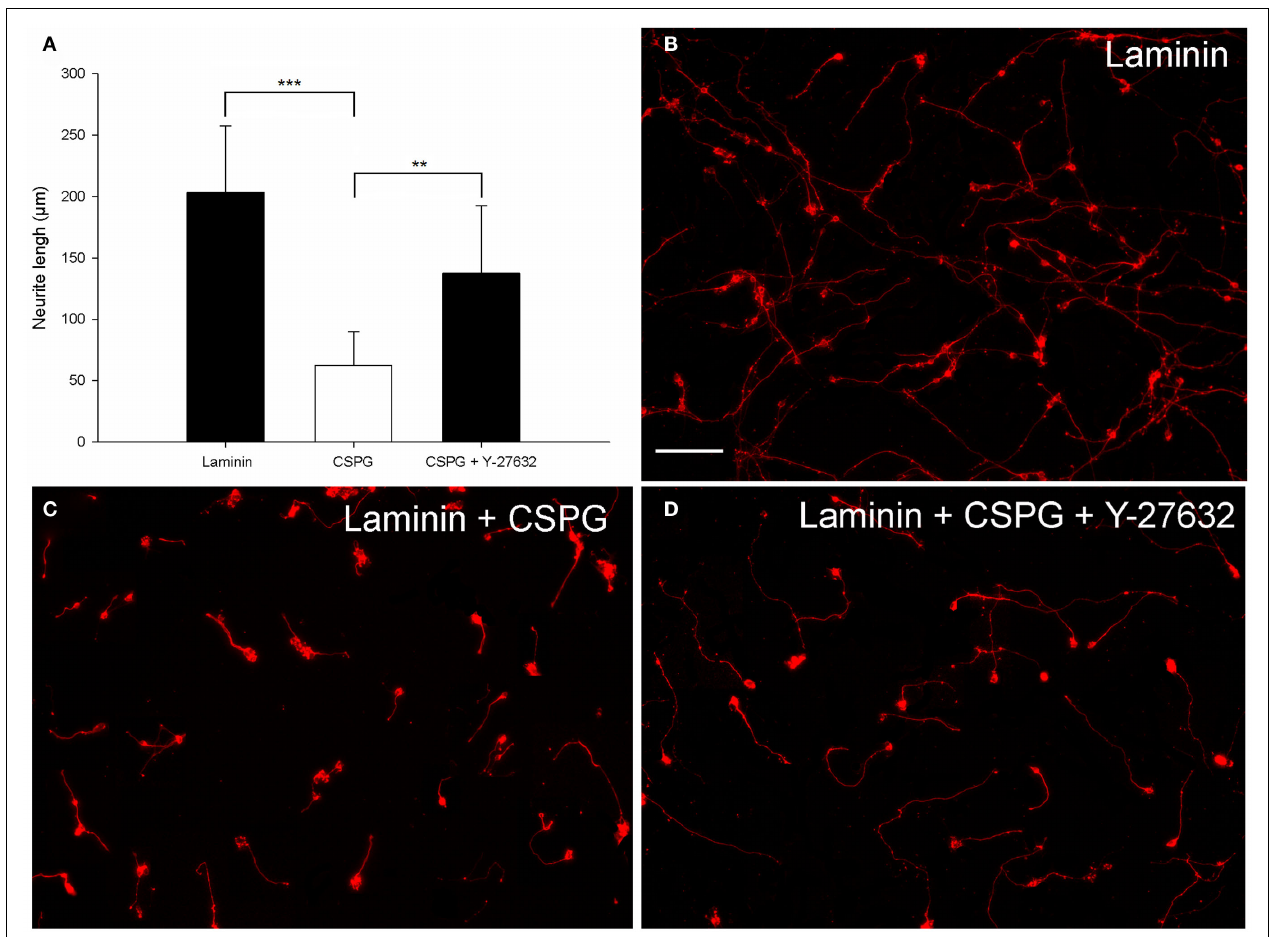
substrate in the presence ofY-27632 compared to CGNs cultured on the CSPG substrate withoutY-37632.Values represent mean and SD; analysis was performed using one way ANOVA with Dunnett’s post hoc tests comparing to CSPG substrate ( ∗∗∗ P < 0.001, ∗∗ P < 0.01), n = 8. (B) Non-inhibitory laminin substrate. (C) Neurite outgrowth is inhibited by the CSPG substrate. (D) The ROCK inhibitorY-27632 can promote CGN neurite outgrowth and overcome the CSPG inhibition. Scale bar: 100 μ